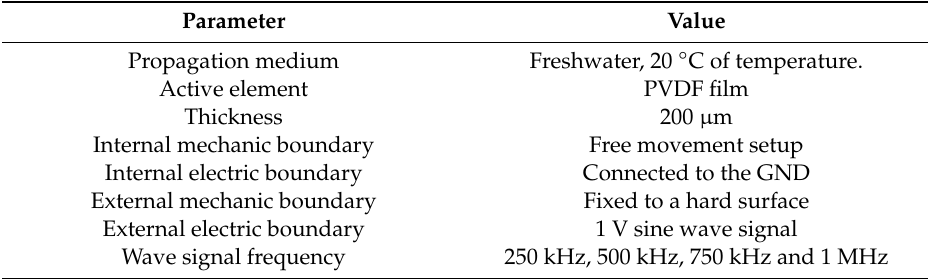
Table 3. Parameters configuration for the acoustic transducer finite element simulation.